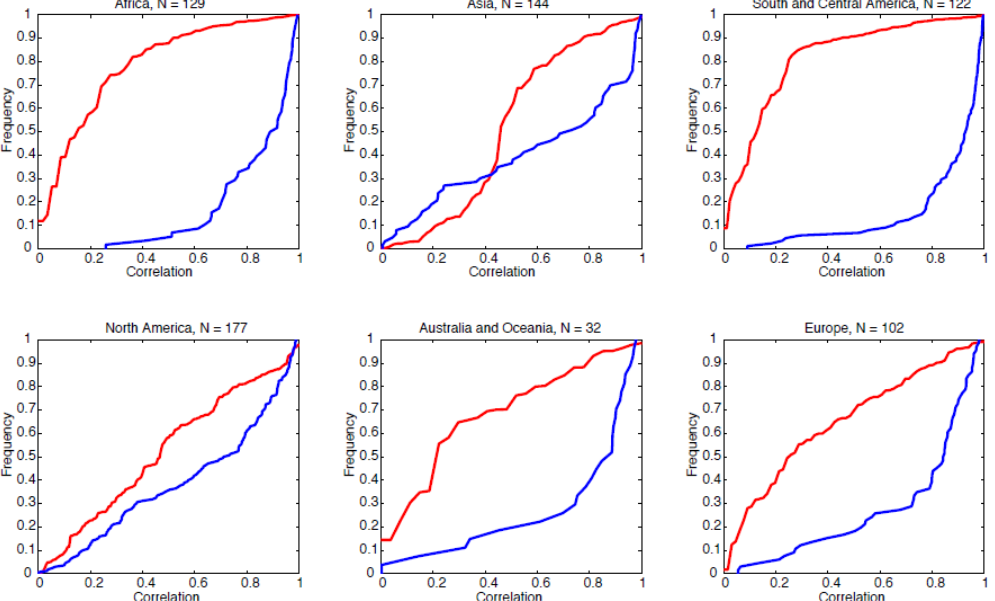
Figure 7. Cumulative distribution function of river discharge correlations of ERA-Interim (red) and ERA-Interim/Land (blue) with GRDC data clustered by